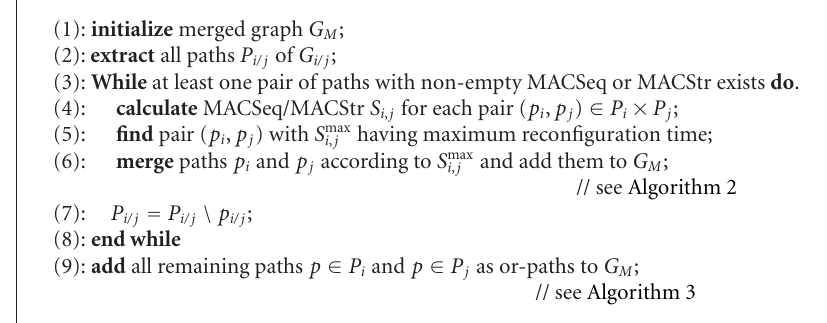
Algorithm 1: Merging two data flow graphs G i and G j .